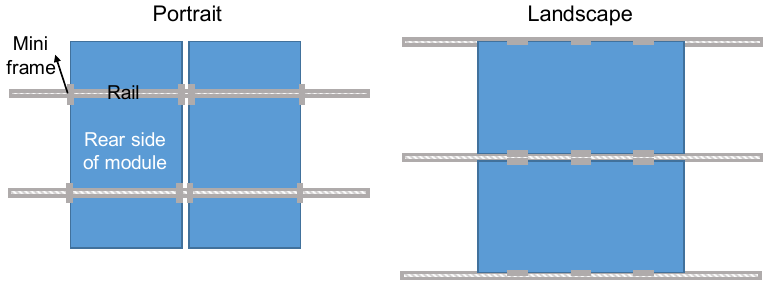
Figure 12. Two installation profiles of modules with mini frames.